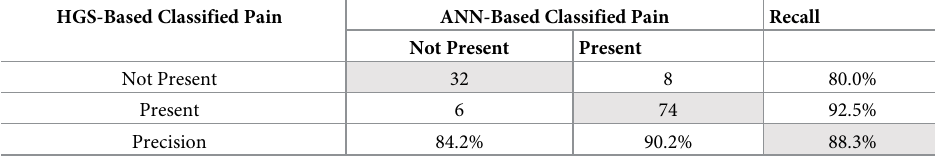
Table 8. Confusion matrix between the data classified by the ANN-based classifier and HGS, described on two lev- els of pain. HGS-Based Classified Pain ANN-Based Classified Pain Recall Not Present Present Not Present 32 8 80.0% Present 6 74 92.5% Precision 84.2% 90.2% 88.3% Gray cells indicate the correct predictions in each class (accuracy). ANN: Artificial Neural Network. HGS: Horse Grimace